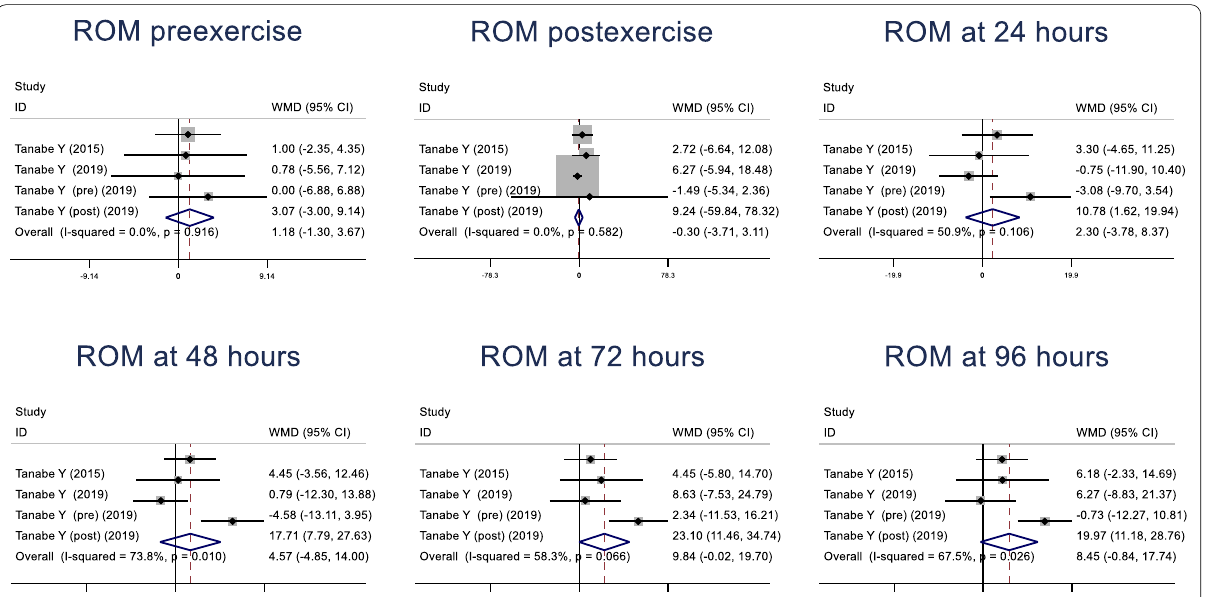
groups. In terms of ROM, no difference between the two groups in all follow-up time was shown. After all outcomes were pooled and the sources of heterogeneity were explored by meta-regression analysis, the differ- ences of all co-variables were shown to have no effect on all outcomes.